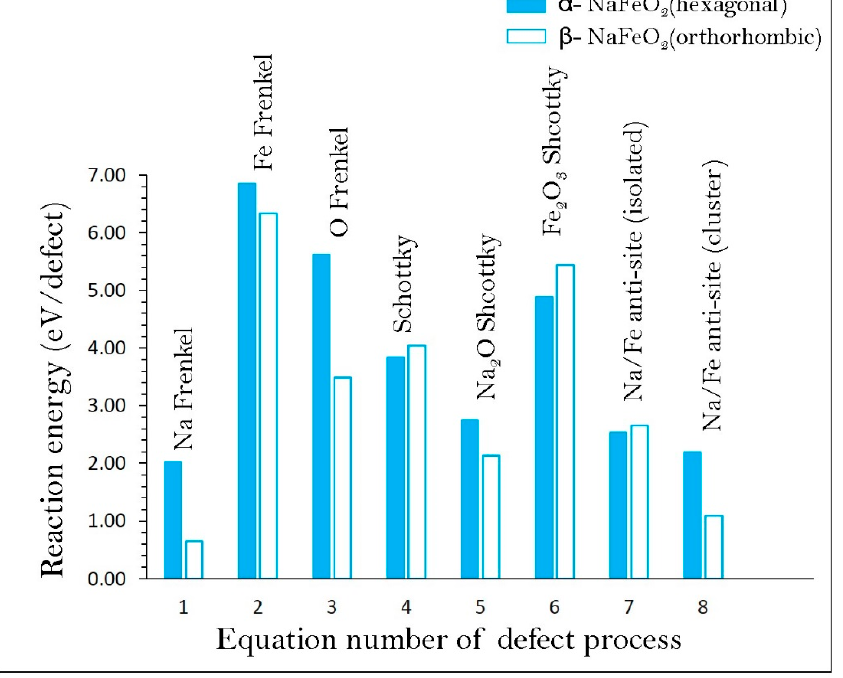
Figure 2. Energetics of intrinsic defect process in α - and β -NaFeO 2 .